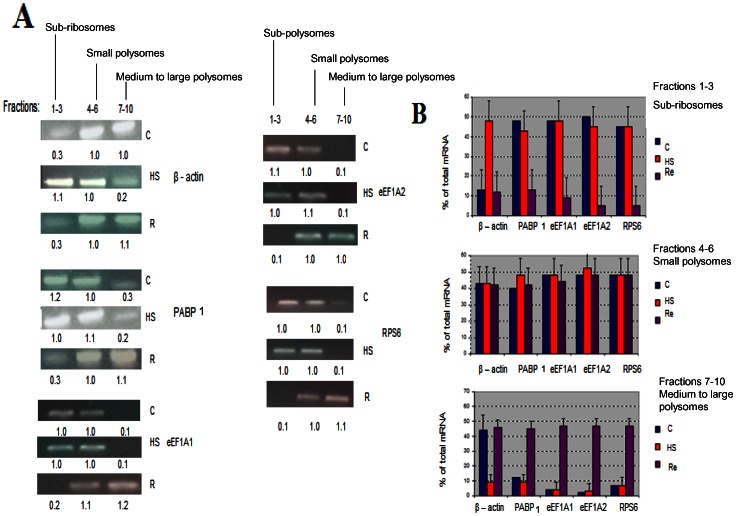
The polysomal distribution of mRNA following heat shock and recovery.Cell lysates were prepared as described in materials and methods and the 12.000×g supernatant fraction of the cell lysate was centrifuged in a 12 mL 10–50% sucrose gradient at 100,000×g in a Beckman SW 41Ti rotor for 3 h. Gradient fractions of approximately 1 mL each were collected and fractions 1–3, 4–6 and 7–10 were pooled together. Total cellular RNA from each pooled fraction was isolated using the Trizol RNA isolation kit as described in materials and methods. A) The abundance of PABP1, eEF1A and RPS6 and β -actin mRNA levels in each fraction was measured by RT-PCR as described in materials and methods section. Each RNA fraction was also subjected to the PCR step without the prior reverse transcription step to determine DNA contamination in our samples, and none was found (results not shown). The amplicons were analyzed by 1% agarose gel electrophoresis, and quantified by scanning the image as described in materials and methods. B) Representative results of two separate experiments. The distribution of mRNA in the sub-polysomal region (fraction numbers 1–3) and the polysomal region (fraction numbers 7–10) of the gradient was determined by quantifying the mRNA level in each fraction using an arbitrary scale. The value of mean ± standard error was derived from two separate experiments.